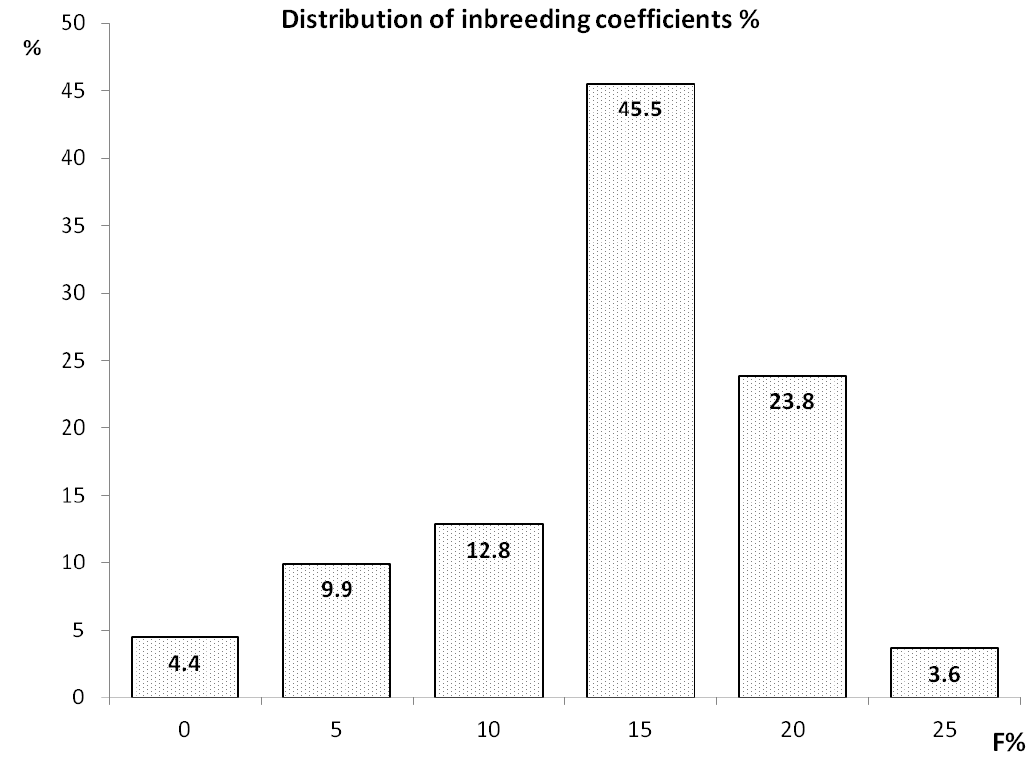
Figure 3. Distribution of inbreeding coefficients (%).